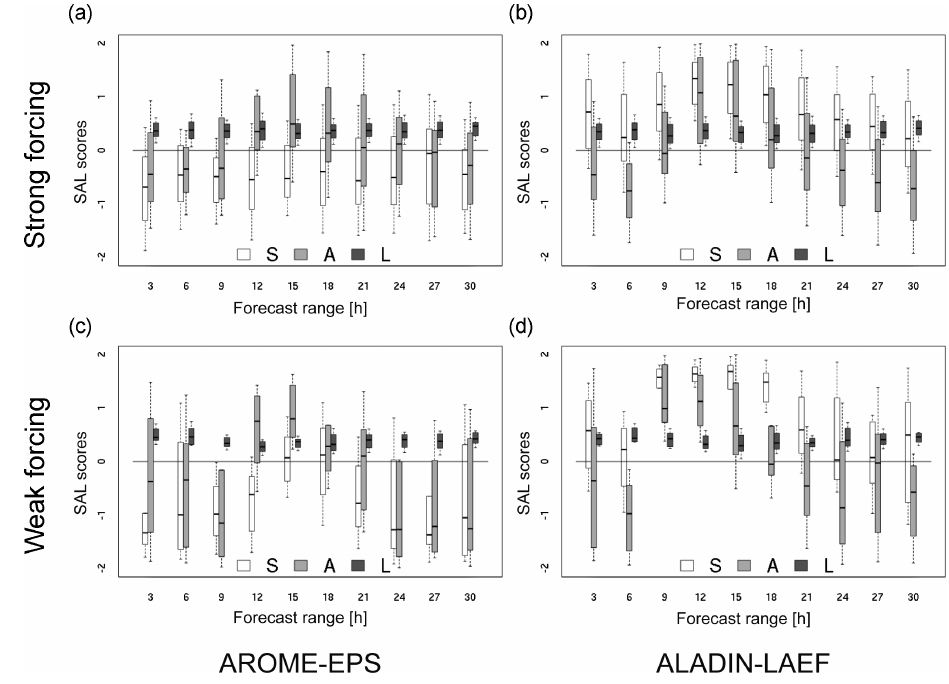
Figure 7. Time evolution of SAL scores for AROME-EPS (left) and ALADIN-LAEF (right) for different forecast ranges in region West. Upper panels (a) and (b) show results for days with strong synoptic forcing, lower panels (c) and (d) for weak synoptic forcing. The boxes are created based on the scores of all individual ensemble